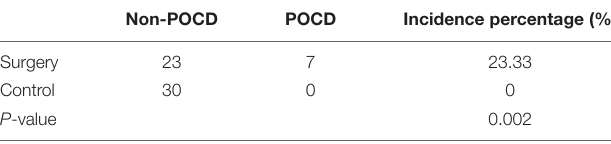
TABLE 3 | Comparison of cognitive function between the two groups. Projects